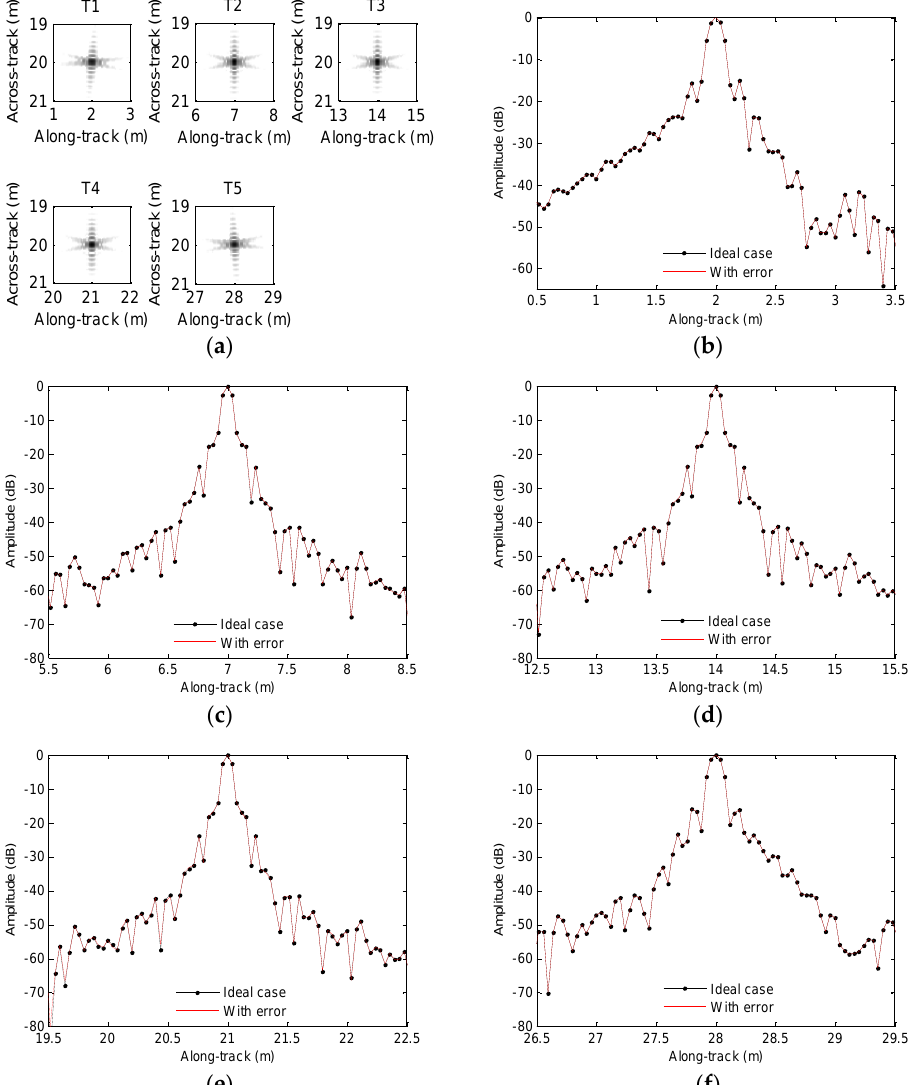
Figure 6. Processing results with the sawtooth sway: ( a ) imaging result; ( b ) slice of T1; ( c ) slice of T2; ( d ) slice of T3; ( e ) slice of T4; ( f ) slice of T5.